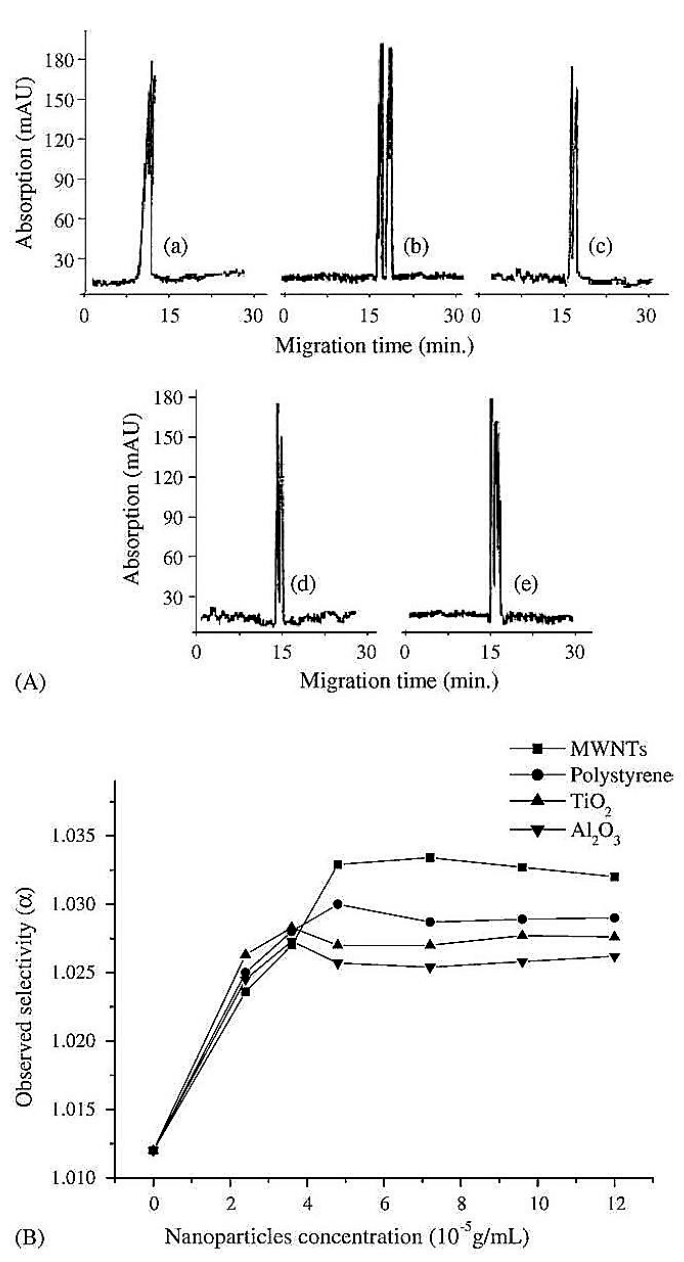
Figure 1. Enantioseparation with CD-MWCNTs “Reproduced with permission from N. Na et al. [48]. Copyright Elsevier, 2006”. ( A ) Different electropherograms showing the effect of CD-MWCNTs on the chiral separation of clenbuterol ( a ) only CD used; ( b ) CD-MWCNTs; ( c ) modified-PS nanoparticles; ( d ) modified-TiO 2 nanoparticles; ( e ) modified Al 2 O 3 nanoparticles. ( B ) Change in enantioseparation based on variation in the concentration of the modified nanoparaticles.